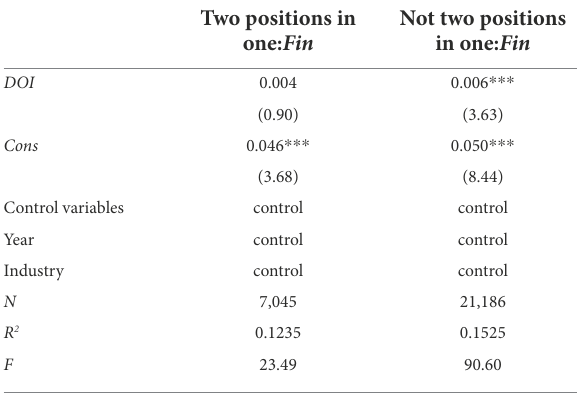
TABLE 11 Sample regression results of whether the chairman and general manager are united in two positions. Two positions in one: